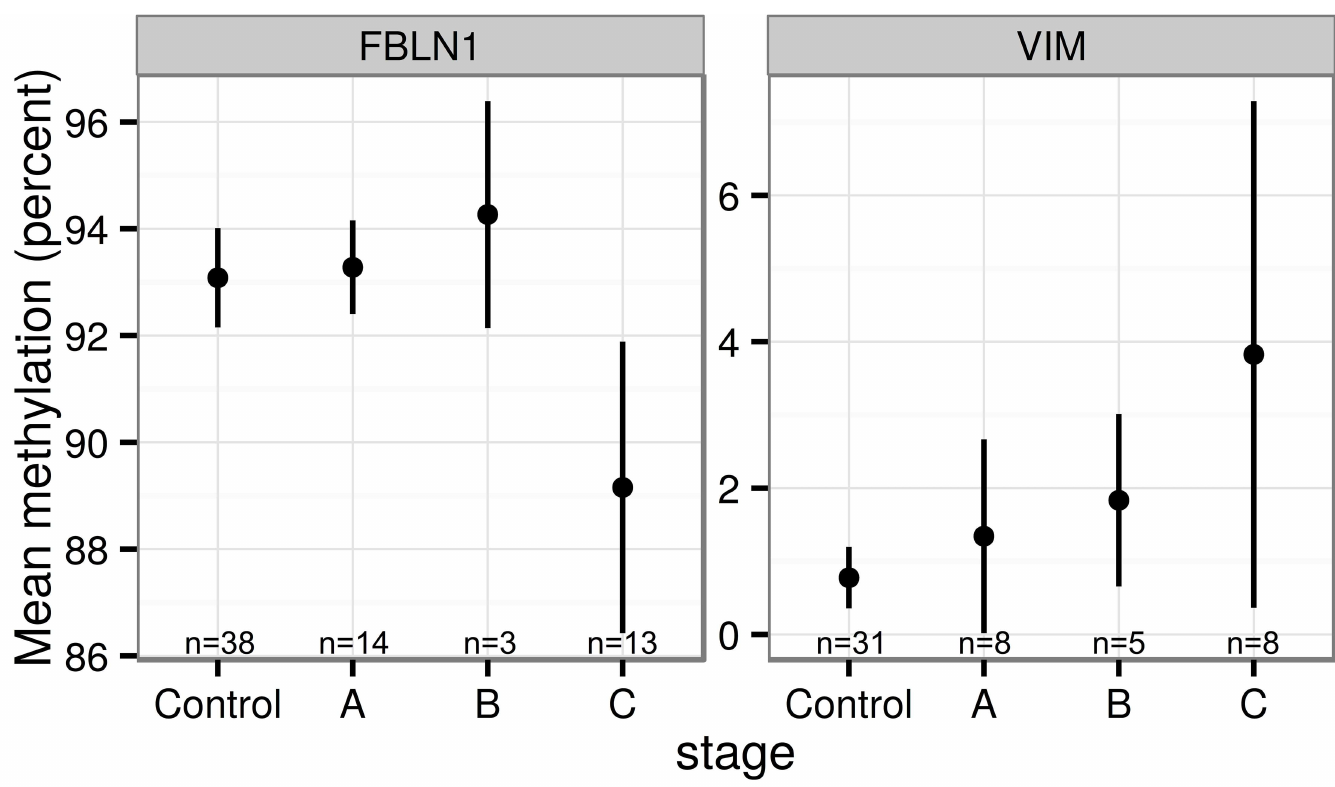
Fig 4. Mean methylation proportions and 95% confidence intervals for HCC cases by tumor stages. A, B and C (BarcelonaClinic Liver Cancer stagingsystem) and controls from France.